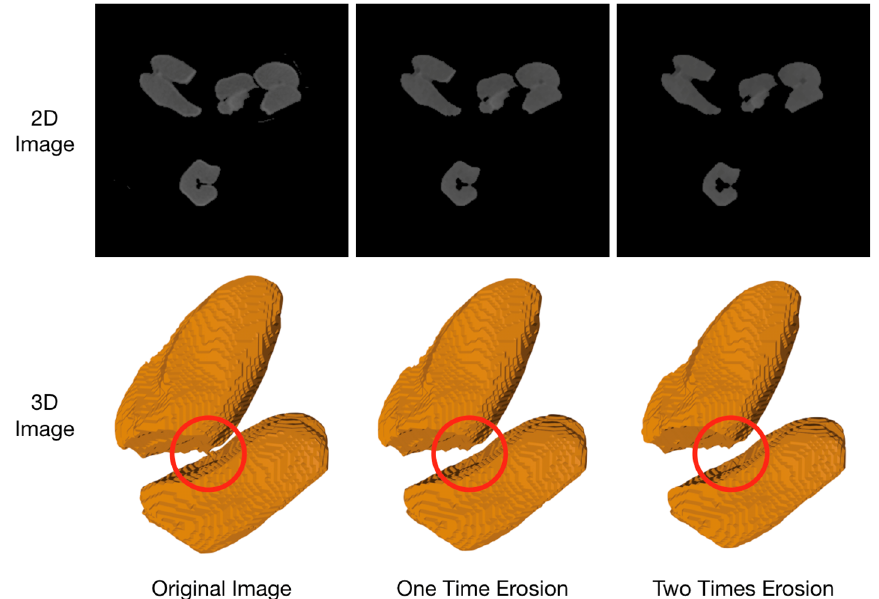
Figure 10. The 3D morphological erosion for separating connected objects. Left one is before erosion processing, we can see the adhesion between the right two grains; Middle and right images are the grains after one and two steps of erosion. The top row are three 2D images and the bottom row are the 3D views, correspondingly. In the red circles, we can see the adhesion has been removed, and each connected component is one grain.